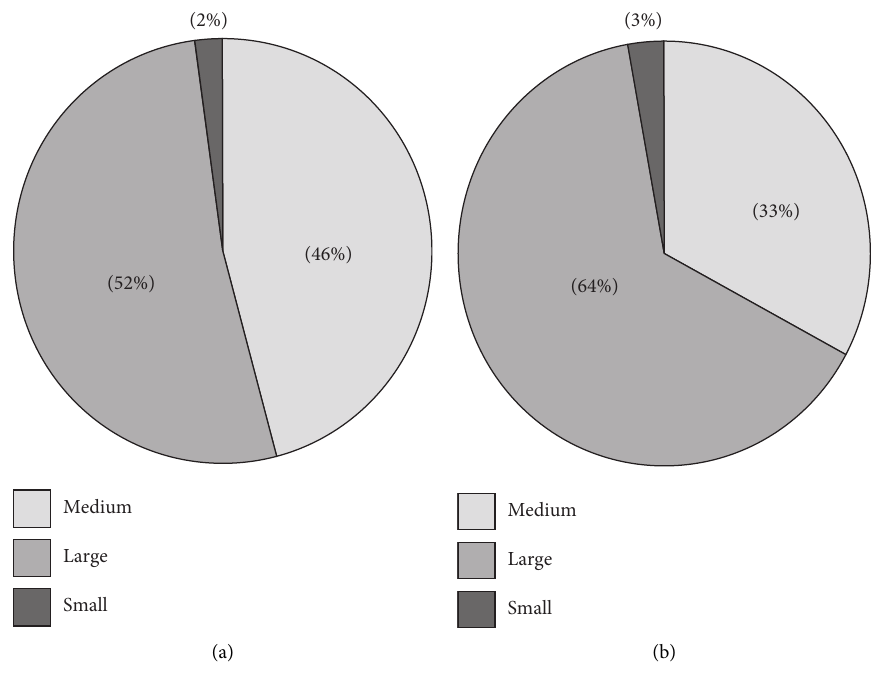
Figure 8: Productivity characteristics of 146 FFNC ecotypes. (a) Fruit length. (b) Seed